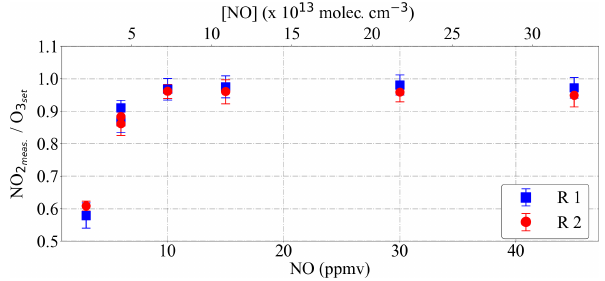
Figure 10. PeRCEAS measurement of O 3 mixing ratios up to 100ppbv for different [NO] in the addition gas using DUALER II. NO is scaled in ppmv and molec.cm − 3 . The O 3 conversion is com- pleted when the NO 2measured / O 3set ratio at the calibrator reaches unity. R1: PeRCEAS reactor 1 (blue squares); R2: PeRCEAS reac- tor 2 (red circles).